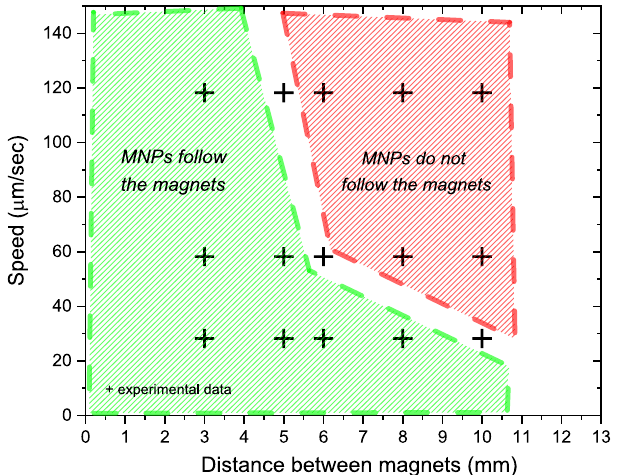
Figure 5. Stability window for the CSC upon translation in the 500 µm capillary. Crosses mark the experimental data while green and red regions delimitate the parameter spaces where a CSC solidly follows the magnets or not, respectively. The data points corresponding to 5 mm to 120 µm/s, 6 mm to 60 µm/s, 10 mm to 30 µm/s gave not reproducible experimental results in terms of stability and were excluded from the green/red